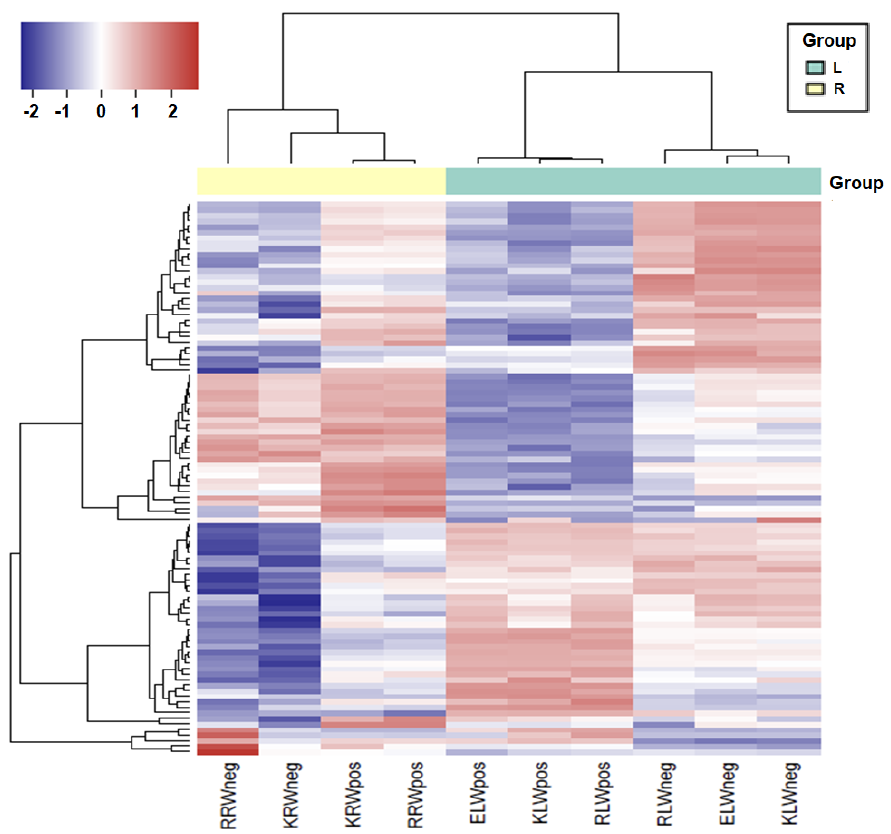
Figure 2. Heatmap showing differential expression of the top 200 sRNAs among all the samples. Dark shades indicate higher expression and light shades indicate lower expression. Colour key indicates the intensity associated with normalized expression values.